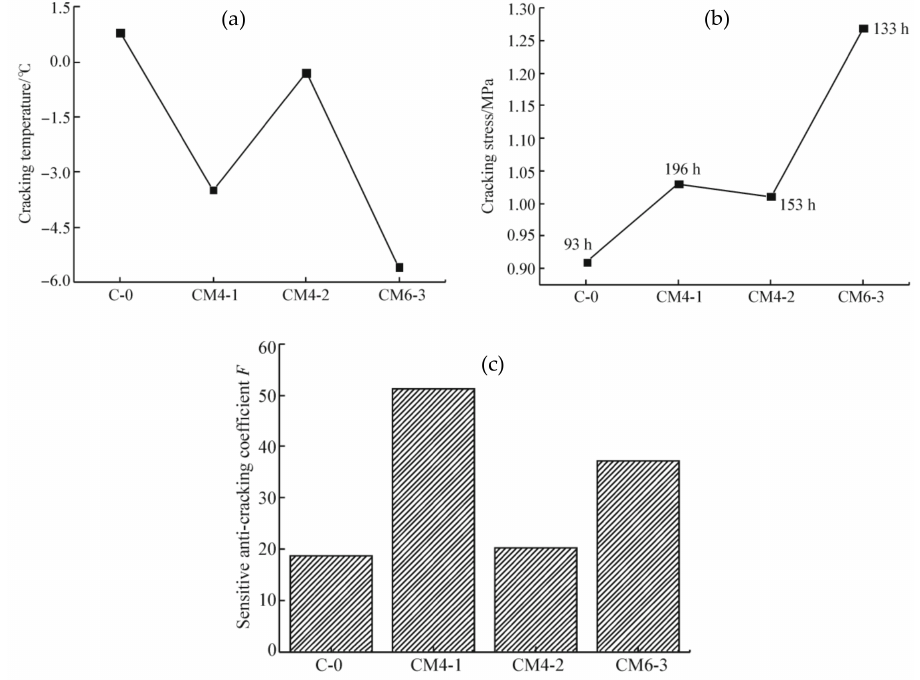
Figure 9. Cracking resistance of MgO incorporated concrete: ( a ) cracking temperature, ( b ) cracking stress, and ( c ) anti-cracking coefficient (reprinted with permission from Ref. [71], 2011, Springer